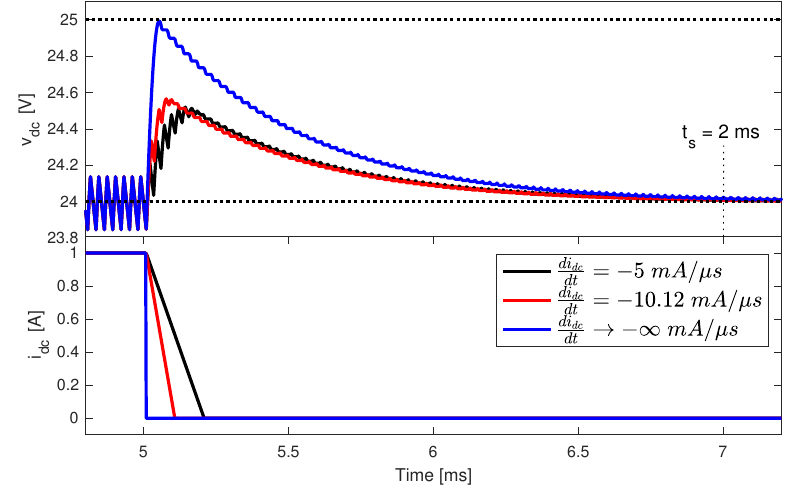
Figure 9. Validation of the capacitor design